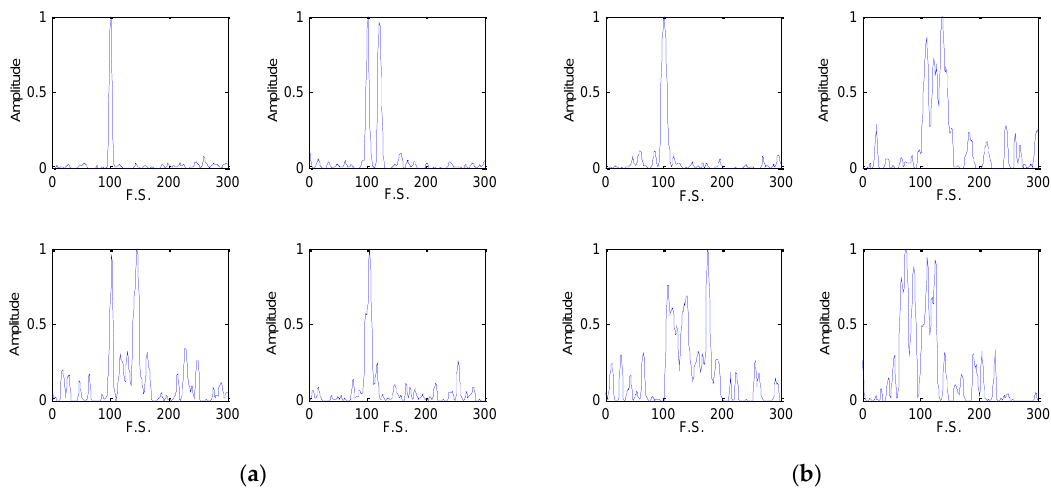
Figure 5. The EC-STFT of eight type radar emitter intra-pulse signals at −5 dB: ( a ) EC-STFT of NS, BFSK, QFSK and BPSK; ( b ) EC-STFT of QPSK, LFM, NLFM and FRANK.